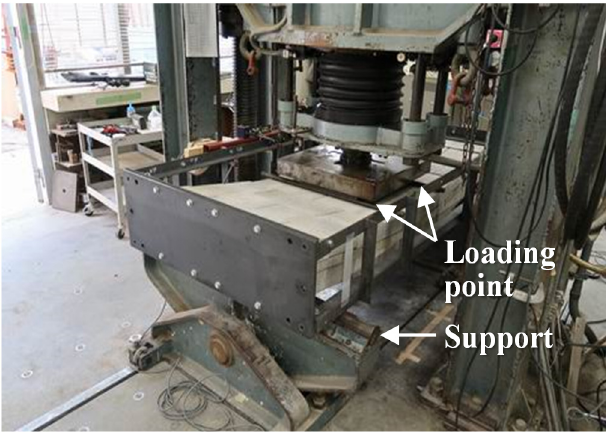
Figure 20. Overall view of four-point bending test.